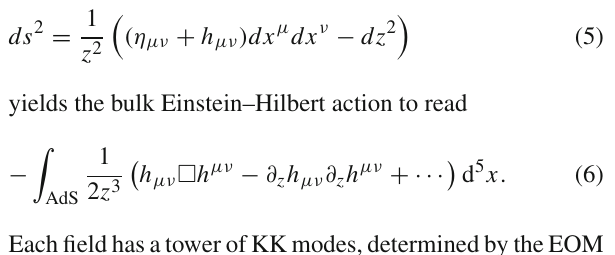
A KK-type splitting of higher spin- S , with S ≥ 3, string , modes are described by the rank- S tensor fields, ψ N ... N S 1 corresponding to a spin- S state in QCD. Gauge invariance usually used [37] to derive EOMs for the spin- S resonances. In fact, the existence of kinetic terms of higher spin- S fields in AdS, with the above gauge invariance yields the = 0 [6]. This gauge is pre- axial gauge choice ψ 5 N ... N S 2 ( x μ , z ) = z 2 ( 1 − S ) ζ μ ( x μ ) . Hence, a served under ζ μ ...μ ...μ S S 2 2